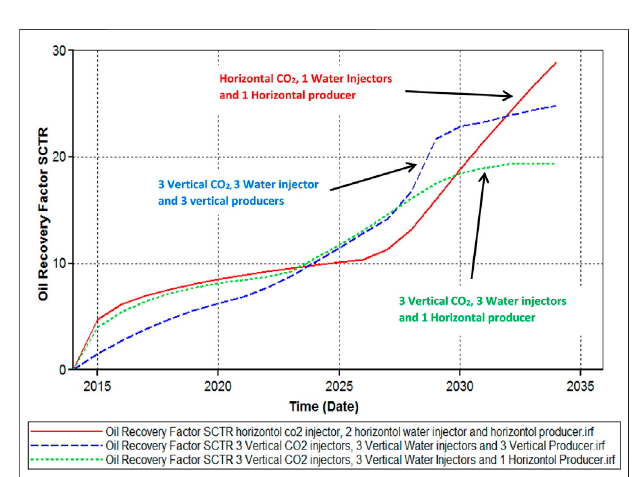
FIGURE10| Oilrecoveryfactorvs.timeforthethreeexaminedcases.In all cases, CO 2 was injected into the aquifer which was followed by water